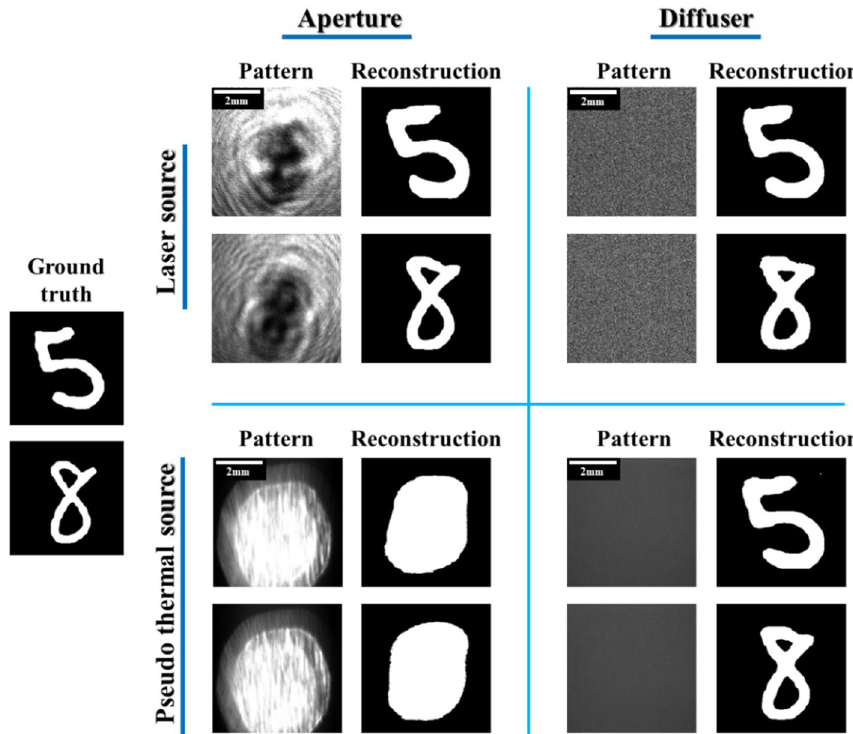
Fig. 2 Experimental results of different channels to transmit information under coherent and incoherent illumination. Two digits “5” and “8” are used as the ground truths. For each case, the recorded patterns and the corresponding reconstructed images are shown side by side. (Upper panels) Under coherent illumination, the recorded patterns after the aperture are the diffraction patterns of the input objects. The trained network can reconstruct the corresponding images. After inserting the diffuser, the camera records high contrast speckle patterns, and the aperture channel is encoded by the randomly distributed refractive index on the diffuser. Information can still be delivered to the detection plane and extracted by deep learning. (Lower panels) Under incoherent illumination, through the aperture, no image can be extracted from the pattern. But with the presence of the diffuser, images can again be well predicted from the speckle patterns, although the speckles are of lower contrast than those formed under coherent illumination. The rain effect on the recorded patterns, i.e., the pattern has an appearance of rain falling on a window, in the aperture case is due to the rotating of the diffuser to generate the pseudo thermal